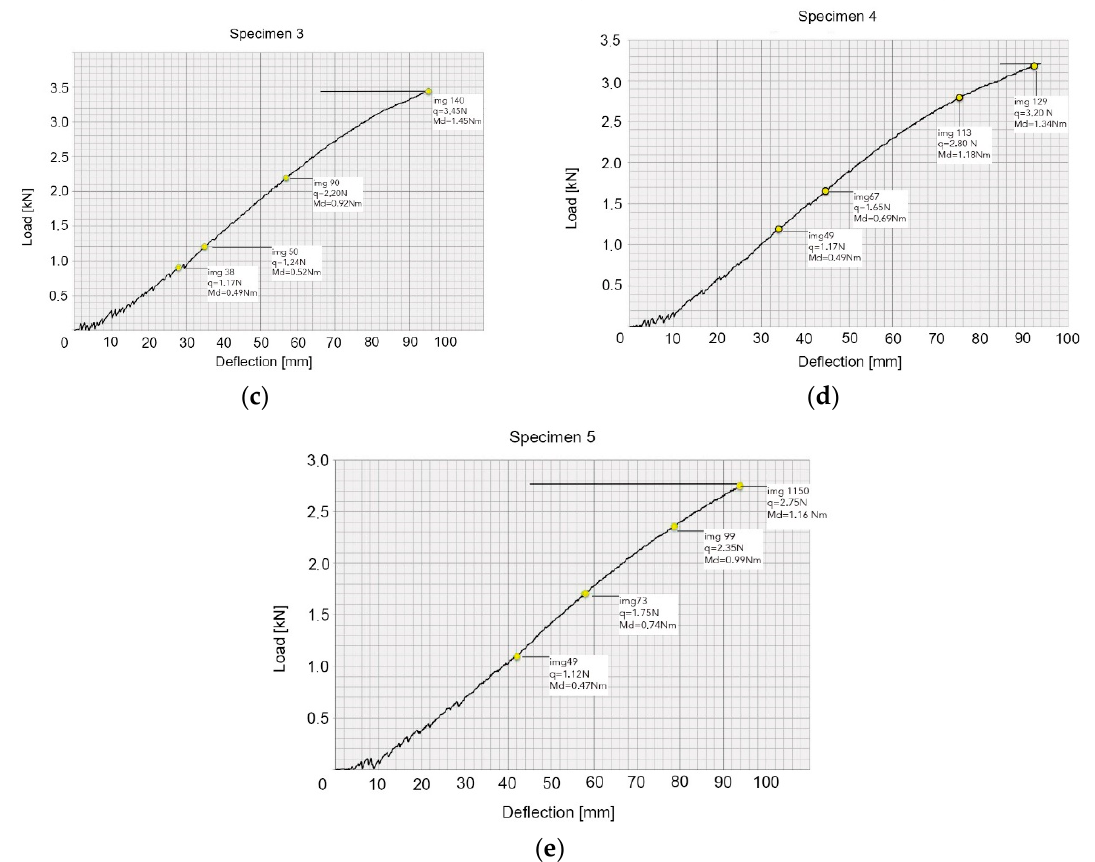
Figure 8. Load-deflection diagrams obtained in the test: ( a ) Specimen 1; ( b ) Specimen 2; ( c ) Specimen 3; ( d ) Specimen 4; and ( e ) Specimen 5.